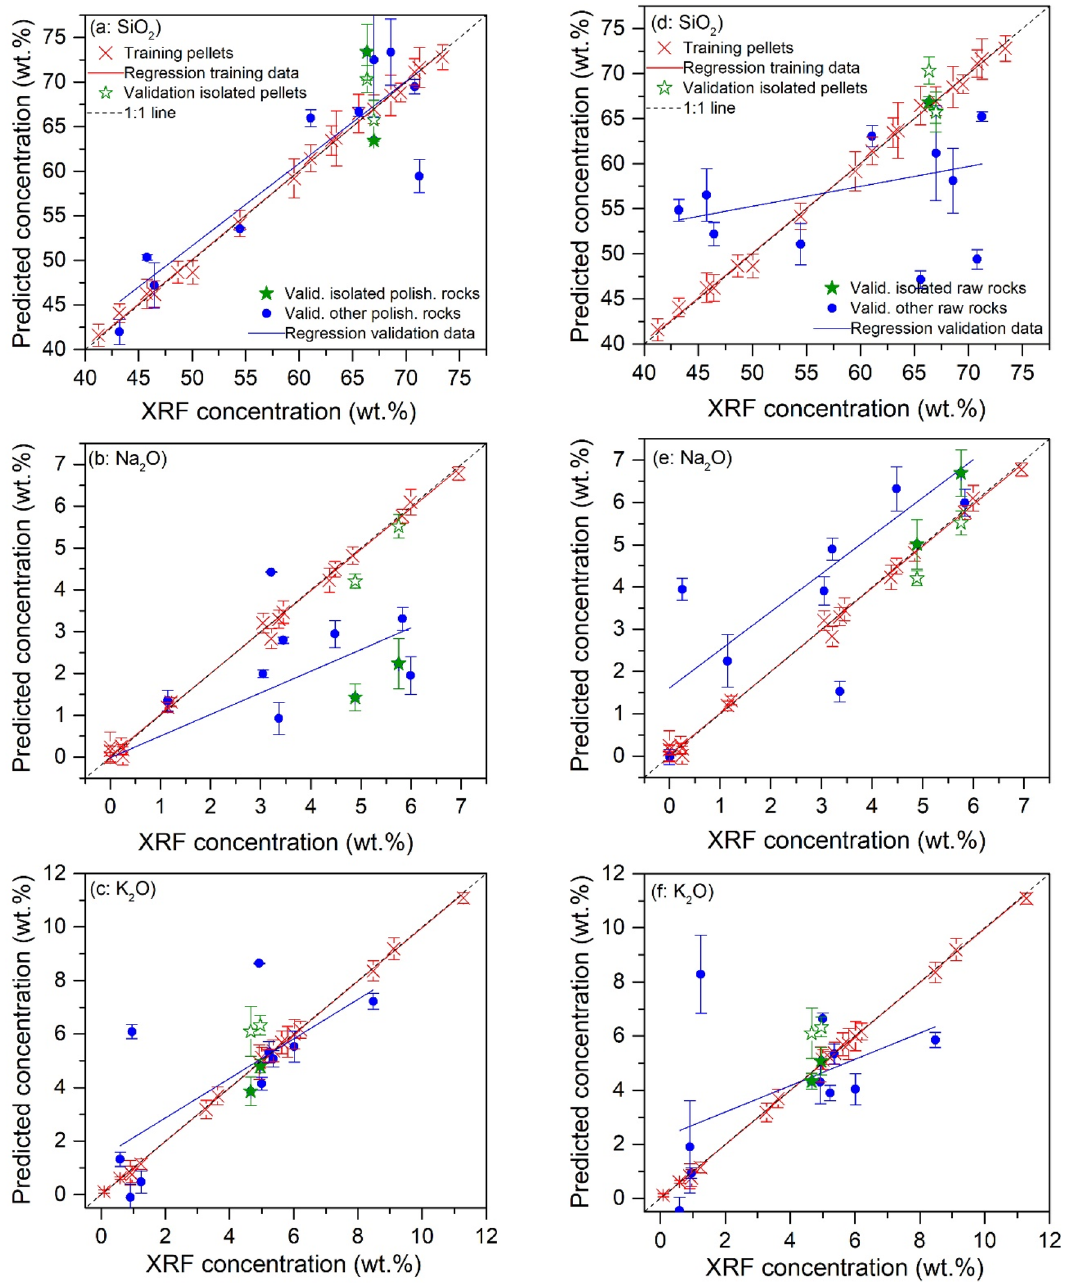
Figure 6. Presentation of the machine learning-based calibration models respectively for the 3 compounds SiO 2 ( a , d ), Na 2 O ( b , e ) and K 2 O ( c , f ), with training data (red crosses) and their linear regressions (red lines); validation data of the 2 isolated pellets (open green stars); validation data of the validation polished ( a – c ) and raw ( d – f ) rocks (solid blue points) including isolated polished and raw rocks (solid green stars), together with their linear regressions (blue lines). Ground-truth diagonals are plotted in dotted lines in the figures as a reference for the models. The error bars of the presented data correspond to the standard deviations ( ± SD ) of the calculated or predicted concentrations for a given training or validation sample. See the text for the details of standard deviation 15 individual values generated during the above mentioned 3 × 5 -fold iterations, and the corresponding error bars representing the standard deviation ( ± SD ) of the 15 individually calculated values. Similarly, the validation data are also shown with their mean values together with the error bars corresponding to ± SD . The difference is however, that the individuals concerned by the statistics correspond to the ensemble of 21 pretreated spectra of each validation sample. Linear regressions are further performed respectively for the training and validation data (only for the 12 validation rocks), in order to measure the difference between them. Ground-truth diago-